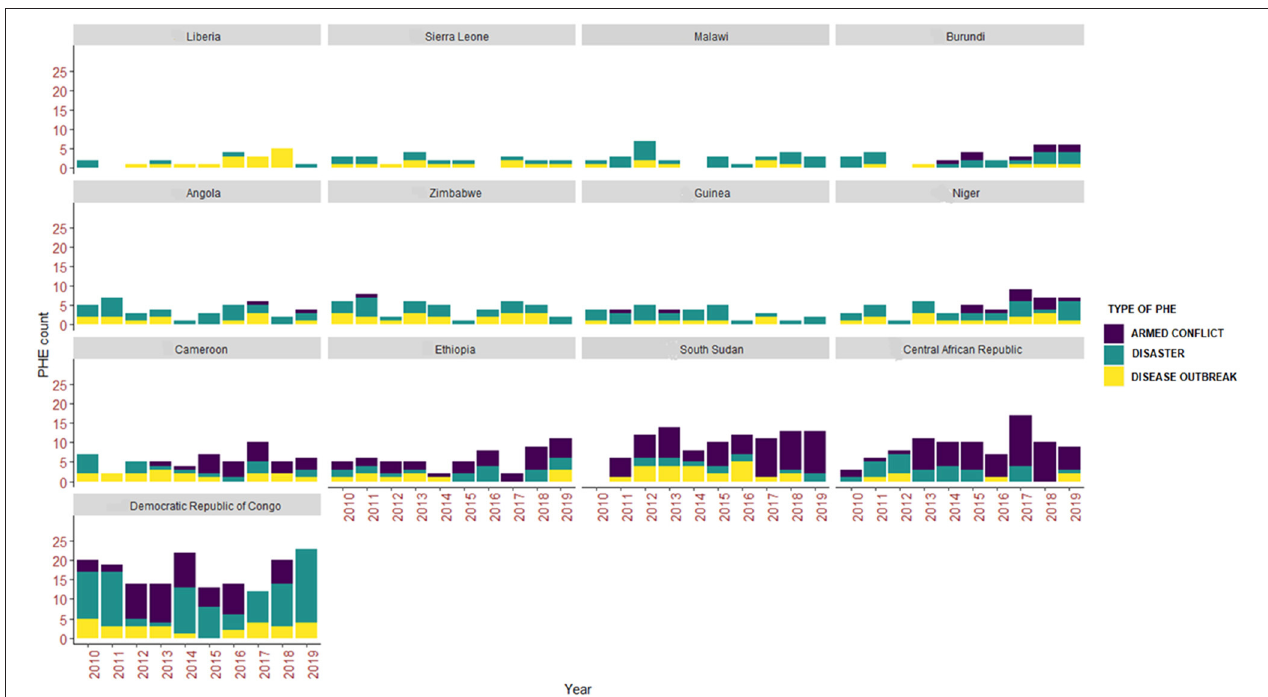
FIGURE 3 | Three types of PHEs recorded in 13 WHO Africa region countries between 2010 and 2019.